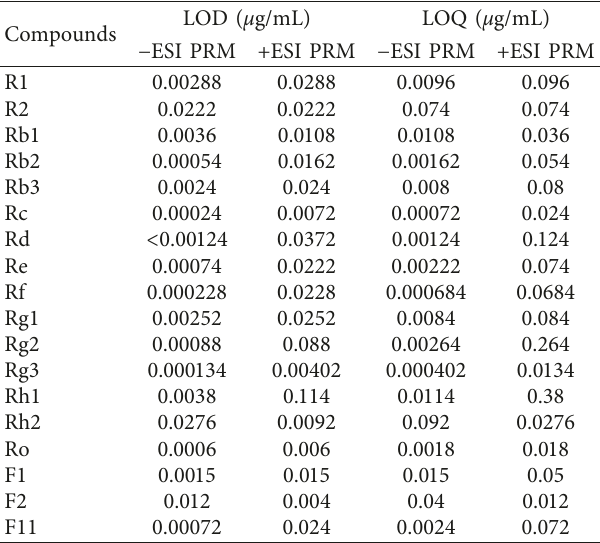
Table 5: LOD and LOQ for the eighteen ginsenosides in ginseng